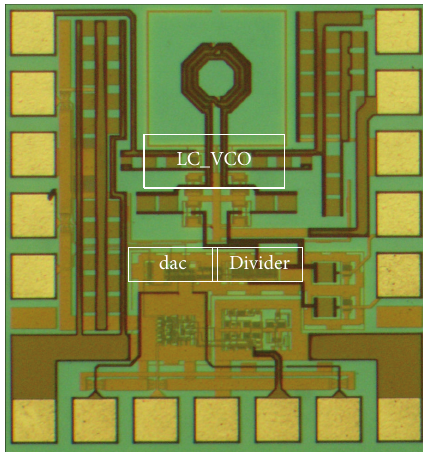
Table 2: The 𝑊/𝐿 values of the differential CMOS amplifier in Figure 5. Figure 6: The microphotograph of the quadrature signal